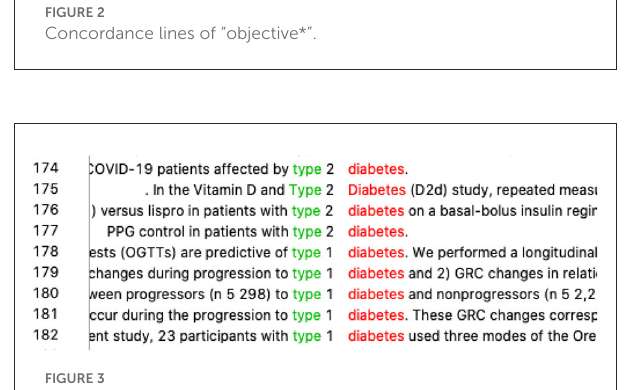
FIGURE3 Concordance lines of “diabetes”.